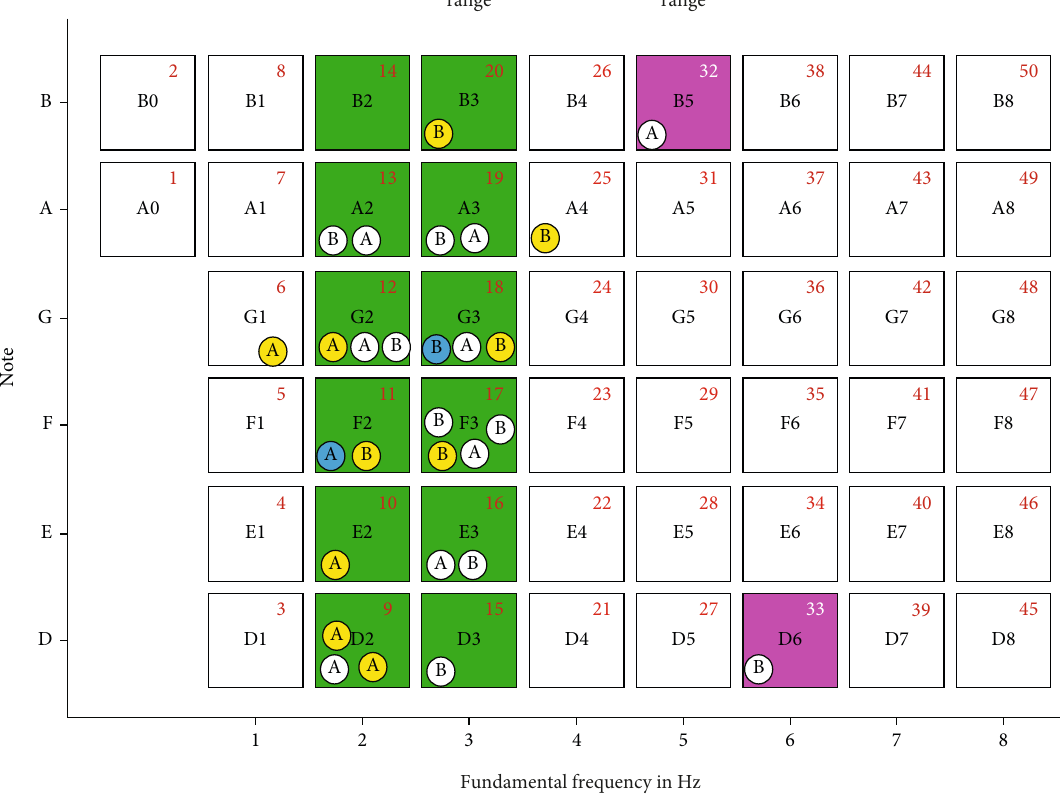
Figure 9: NW-HH. The balloons with the letter (A) represent mean results before the fatigue test, balloons with letter (B) represent mean results after the fatigue test, and the colors indicate the degree of signi fi cance; white balloons are not signi fi cant, blue were mildly signi fi cant, and yellow balloons were signi fi